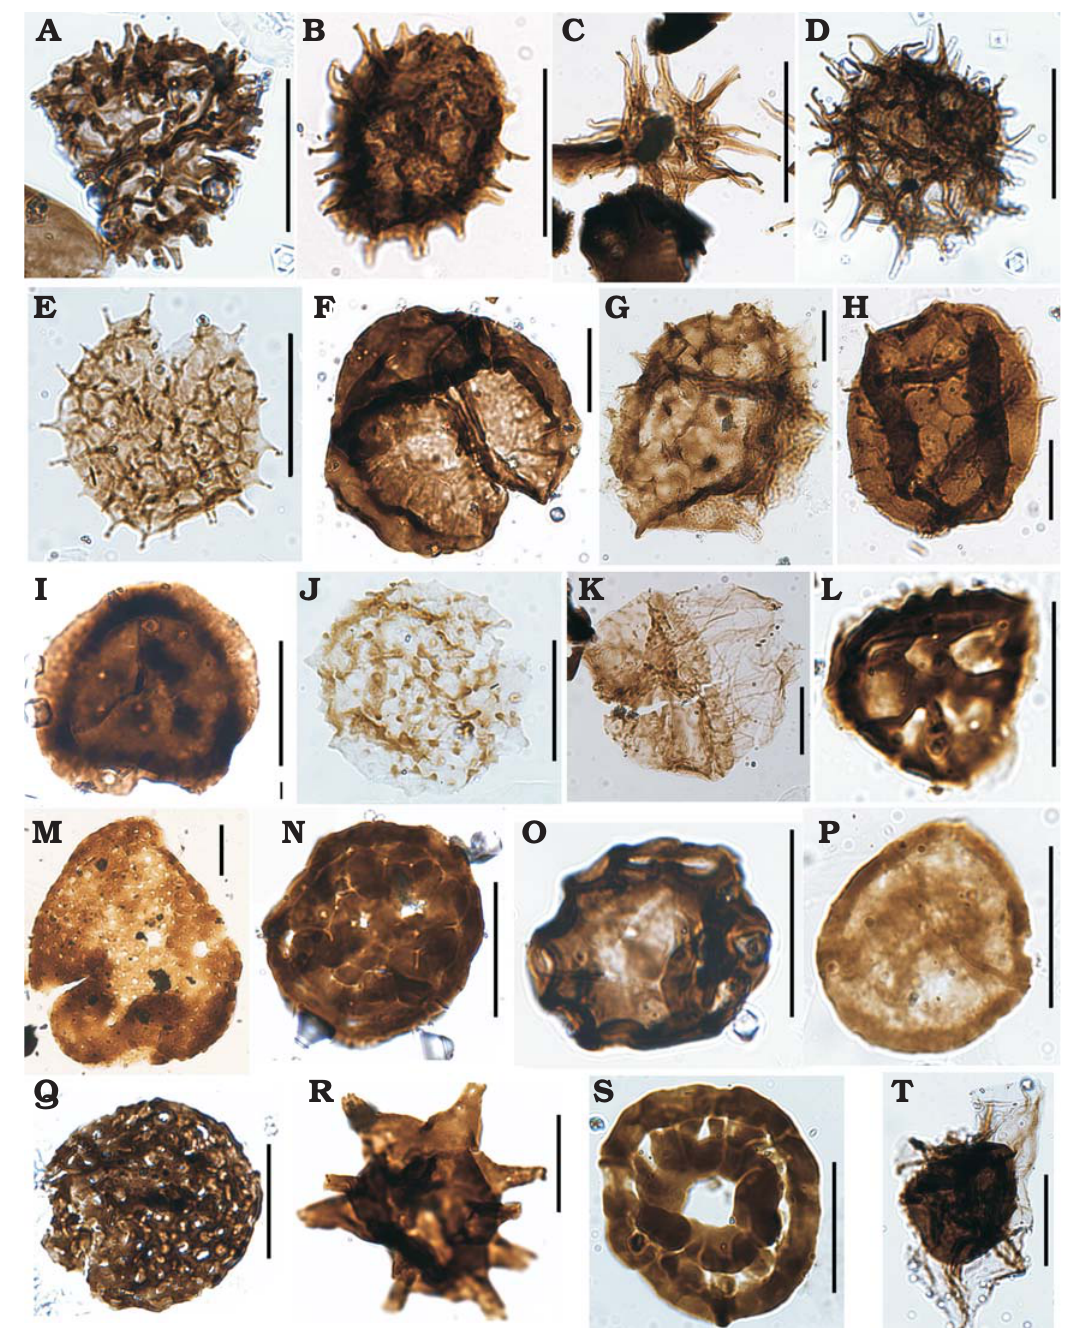
Fig. 5. Palynomorphs from the studied sections of the Los Espejos Formation of Argentina, Quebrada Ancha, Gorstian?–Ludfordian? (A, T), Quebrada Ancha, Ludfordian (B–F, H–K, N, O, Q, R), Cerro La Chilca, Ludfordian (G, L, M, P, S). A . Ammonidium cornuatum Loeblich and Wicander, 1976; MPLP 8-60677 (H27/3). B . Ammonidium ludloviense (Dorning, 1981) Mullins, 2001; MPLP 2-60704 (T22/2). C . Ammonidium maravillosum (Cramer, 1969) Thusu, 1973a; MPLP 7-60736 (S29/1). D . Ammonidium waldronense (Tappan and Loeblich, 1971) Dorning, 1981; MPLP 8-60677 (T50/2). E . Ammonidium sp. A in Mullins 2001; MPLP 7-60736 (N27/1). F . Indeterminated miospore, MPLP 8-60677 (O44/2). G . Baculatireticulatus baculatus Al-Ameri, 1984; MPLP 4-61059 (J45/4). H . Baculatireticulatus sp.; MPLP 7-60736 (N43/2). I . Breconisporites sp.; MPLP 8-60677 (U33). J . Buedingiisphaeridium lu- natum Le Hérissé, 1989; MPLP 4-61059 (D47). K . Carminella maplewoodensis Cramer, 1968; slide MPLP 7-60736 (R26/2). L . Chelinospora cf. can- tabrica Richardson, Rodríguez, and Sutherland 2001; MPLP 5-61060 (U38). M . Chelinospora sanpetrensis (Rodríguez, 1978) Richardson, Rodríguez, and Sotherland 2001; MPLP 7-61062 (C35). N . Chelinospora verrucata var. verrucata Morphon in García Muro et al., 2014b; slide MPLP 8-60677 (K43/1). O . Clypeolus tortugaides (Cramer, 1966a) Miller, Playford, and Le Hérissé, 1997; MPLP 4-62521 (V42/2). P . cf. Concentricosisporites agrada- bilis (Rodríguez, 1978) Rodríguez, 1983; MPLP 6-61061 (H45/1). Q . Confossuspora sp.; MPLP 2-60704 (O42/1). R . Cordobesia uruguayensis (Martinez- Macchiavello, 1968) Pöthé de Baldis, 1977; MPLP 3-60659 (E46/4). S . Coronaspora cromatica (Rodríguez, 1978) Richardson, Rodríguez, and Sutherland, 2001; MPLP 4-61059 (Q28). T . Cymatiosphaera acuminata Mullins, 2001; MPLP 8-60677 (G48/3). Scale bars 20 μ